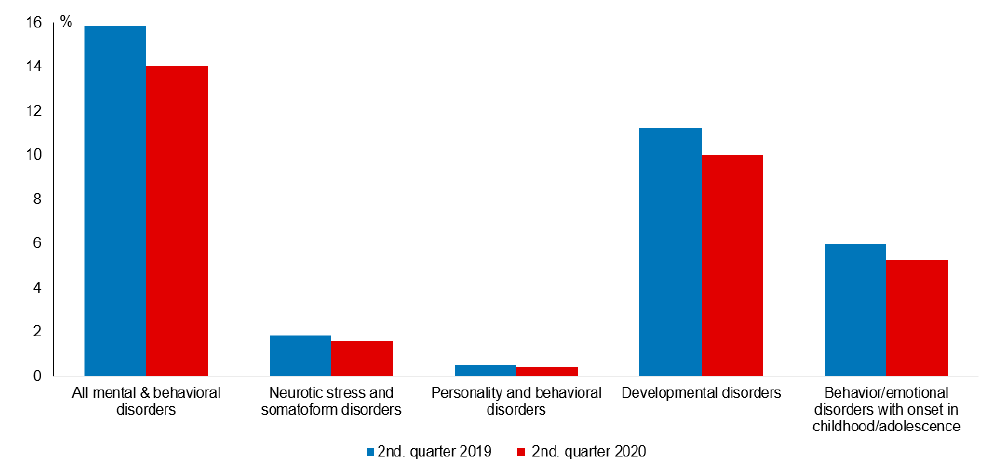
Figure 3. Frequency of diagnosed mental illnesses and behavioral disorders (% of all children) among children aged 1–12 years in the 2nd quarters of 2019 (control) and 2020 (COVID-19 pan- demic).